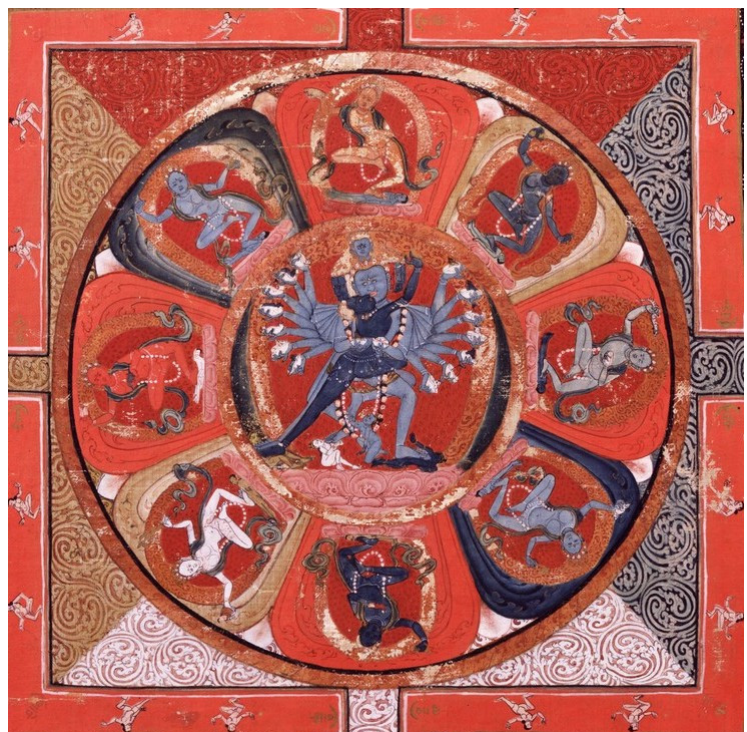
Figure 1. Hevajra and yogin ī s. Among the eight are the four who sing out to Hevajra with songs: in the upper-left is Ca ṇḍ ā l ī , upper-right Ḍ omb ī , lower left Ś avar ī , and lower-right Pukkas ī . (Himalayan Art Resource, Item 444).